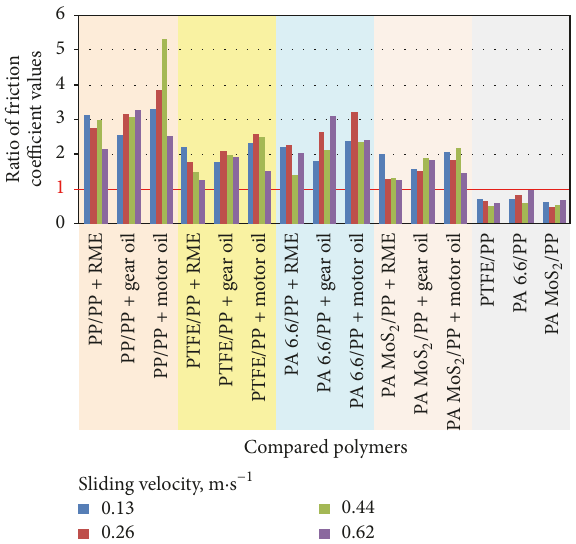
Figure 14: Relations between friction coefficient values for the examined polymers depending on sliding